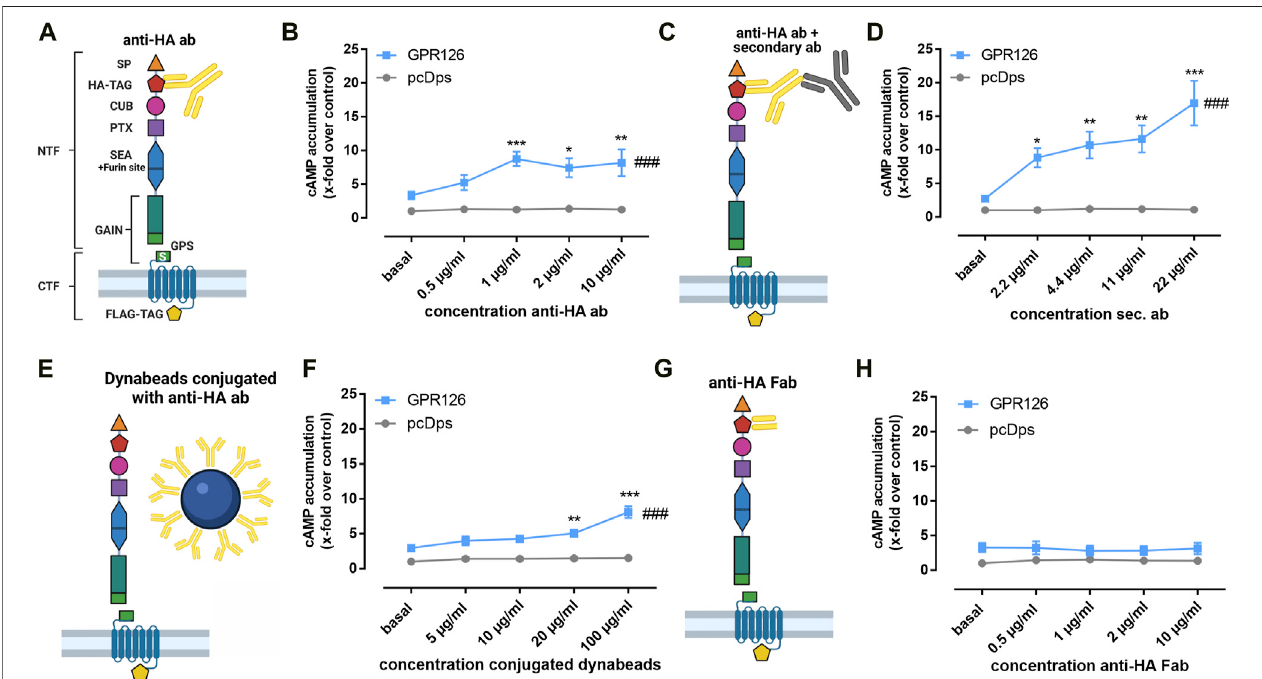
FIGURE1| AntibodiesagainsttheNterminusactivateGPR126. (A) Schematicsetupfortheanti – HAantibody(anti-HAab)stimulationoffull-lengthWTGPR126in cAMP accumulation assays. The N terminus contains the signal peptide (SP, orange triangle), a complement C1r/C1s-Uegf-BMP1 domain (CUB, magenta oval), a pentraxin domain (PTX, purple square), and the sperm protein, enterokinase and agrin (SEA) domain (blue hexagon), including the furin site. The highly conserved GAIN domain (greenrectangle)containstheGPS,whichisfollowedbythe Stachel sequence(S).Inourreceptorconstructs, weinsertedanN-terminalhemagglutinintag (HA-TAG, red pentagon) immediately distal to the signal peptide and a C-terminal Flag tag (FLAG-TAG, yellow pentagon) right before the stop codon. (B) . Different concentrationsofanti – HAantibody(0.5 µg/ml a 3.3µM;1 µg/ml a 6.67µM;2 µg/ml a 13.34 µM;10 µg/ml a 66.7 µM)wereusedtotreatvectorcontrol(pcDps)and GPR126-transfected COS-7 cells (effect of construct p = 0.0410, effect of concentration p < 0.0001, interaction construct × concentration p = 0.0506; two-way ANOVA). Basal cAMP level in pcDps transfected cells: 8.9 ± 0.8 nM/well. (C,D) Ampli fi cation of the cAMP signal of GPR126 with 1 µg/ml of anti – HA antibody and subsequent incubation with different concentrations ofsecondary antibody (2.2 µg/ml a 14.7 µM; 4.4 µg/ml a 29.3 µM; 11 µg/ml a 73.3 µM; 22 µg/ml a 146.7 µM) on vector control and GPR126-transfected COS-7 cells (effect of construct p = 0.0104, effect of concentration p < 0.0001, interaction construct × concentration p = 0.0072;two-way ANOVA). Basal cAMPlevel in pcDpstransfectedcells: 4.2 ±1.0nM/well. (E,F) Paramagnetic Dynabeads ® wereconjugatedwith anti – HA aband used in different concentrations for stimulation of vector control and GPR126-transfected COS-7 cells (effect of construct p = 0.0001, effect of concentration p < 0.0001, interactionconstruct×concentration p < 0.0001;two-way ANOVA).Anempty vector(pcDps) served asanegative control.BasalcAMPlevelinpcDpstransfectedcells: 5.8±0.4 nM/well. (G,H) cAMPaccumulationuponincubationwithindicatedconcentrationsofFabfragment(0.5 µg/ml a 10 μ M;1 µg/ml a 20 μ M;2 µg/ml a 40 μ